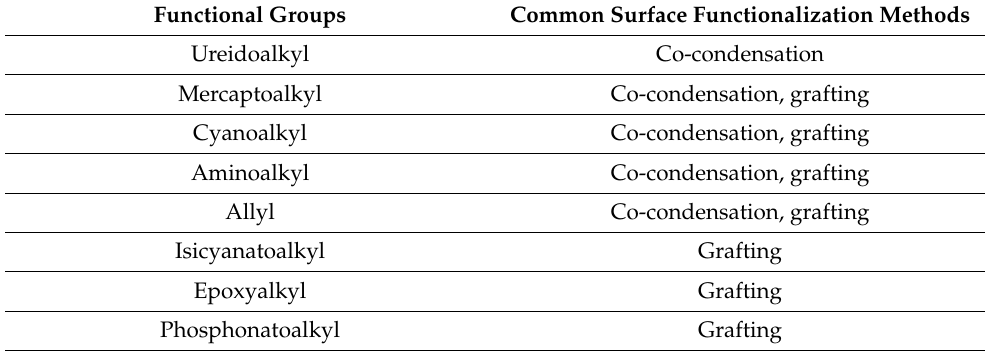
Table 1. Common methods to attach functional groups onto MSNs